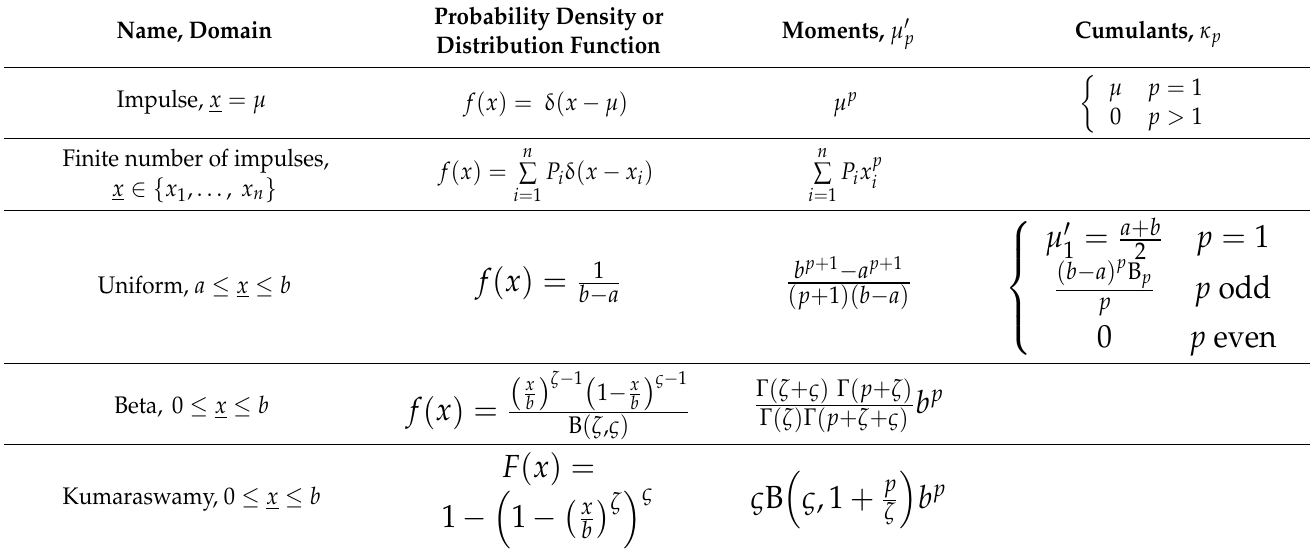
Table 2. Non-central moments and cumulants of common distributions with finite domain (all moments and cumulants